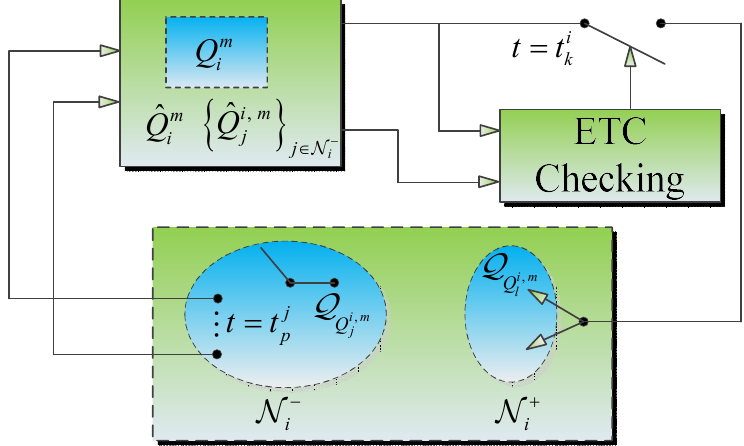
Figure 2. Control architecture for the i -th agent.